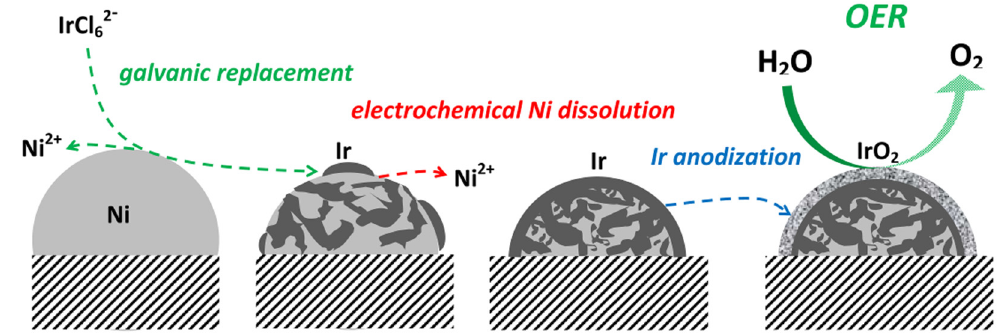
Figure 8. Schematic representation of the formation and morphology of IrO 2 -coated Ir(Ni)/GC deposits, prepared by galvanic replacement of Ni by Ir, followed by anodic growth of IrO 2 on the Ir shell. (Reproduced with permission from [113]. Copyright 2016, American Chemical Sociely).